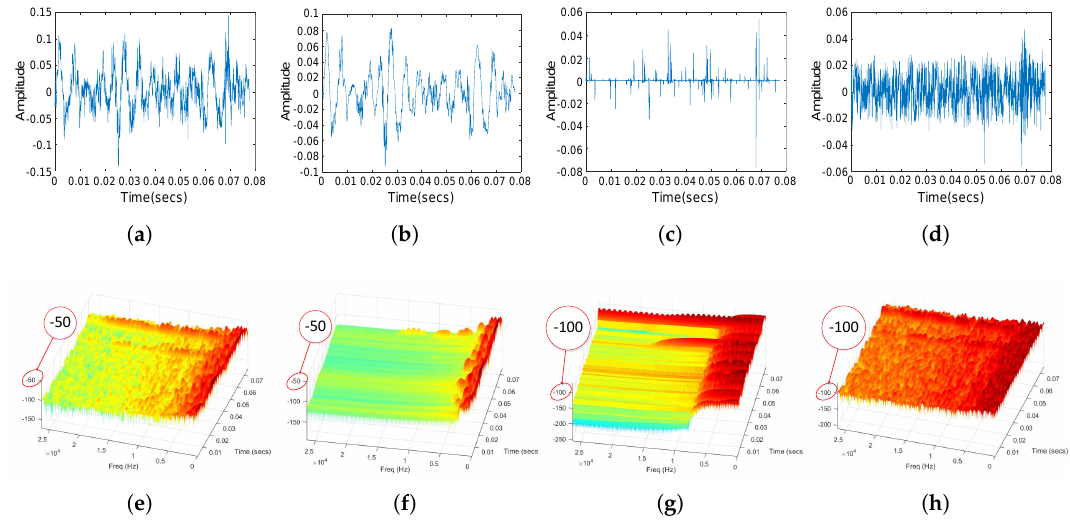
Figure 9. RSSD result. ( a ) Waveform of the originally recorded signal. ( b ) Waveform of the high-resonance component. ( c ) Waveform of the low-resonance component. ( d ) Waveform of the residual component. ( e ) 3-D spectrogram of the originally recorded signal. ( f ) 3-D spectrogram of the high-resonance component. ( g ) 3-D spectrogram of the low-resonance component. ( h ) 3-D spectrogram of the residual component.